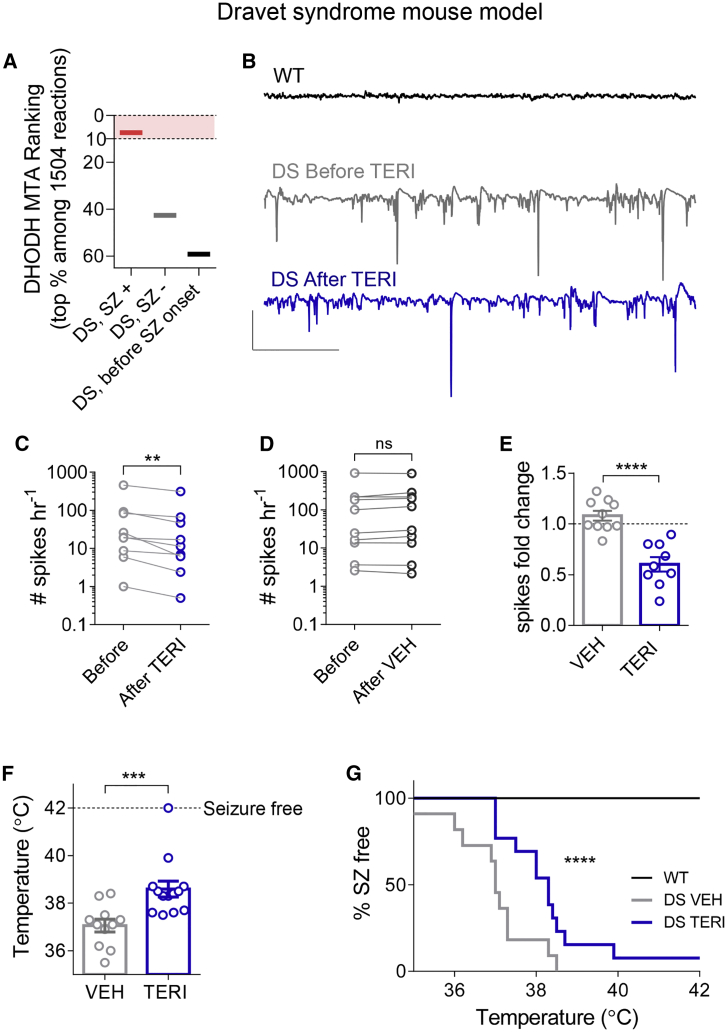
TERI Reduces the Frequency of Interictal Spikes and the Susceptibility to Thermally Induced Seizures in the Mouse Model of DS(A) MTA analysis of hippocampal RNA sequencing data in DS model Scn1a+/− mice (Hawkins et al., 2019). DHODH was ranked within top 10% among analyzed 1,504 metabolic reactions in DS mice with seizures (red line, P24 SZ+ group), but only at 43% in DS mouse strain without seizures (gray line, P24 SZ− group) and at 59% in DS mice before seizures onset (black line, P14 group).(B) Representative traces of LFP recordings in the CA1 stratum radiatum depict normal activity in WT (top trace), interictal activity before i.c.v. injection of TERI (middle trace), and after injection (bottom trace) in DS model mice. Scale bars, 5 mv and 20 s.(C) TERI i.c.v. injection caused a significant reduction in the frequency of interictal spikes (n = 9 mice, p = 0.039).(D) VEH i.c.v. injections did not affect the frequency of interictal spikes (n = 10 mice, p = 0.49).(E) On average, the TERI-treated group displayed a 1.8-fold reduction in the frequency of interictal spikes (same data as in B and C).(F) Repeated i.c.v. injections of TERI for 3 consecutive days increased temperature threshold of thermally induced seizures. Temperature threshold for seizure induction was 37.05°C ± 0.26°C in VEH-treated group (n = 11 mice) and 38.59°C ± 0.33°C in the TERI-treated group (n = 13 mice).(G) Percentage of mice remaining free of behavioral seizures (SZ) at the indicated body core temperatures. All WT mice (n = 8) remained SZ free during the experiment.Wilcoxon matched-pairs (C and D), Mann-Whitney nonparametric test (E and F), and log rank (Mantel-Cox) test (G) were used for the analysis. ∗∗p < 0.01, ∗∗∗p < 0.001, and ∗∗∗∗p < 0.0001. Error bars represent SEM.